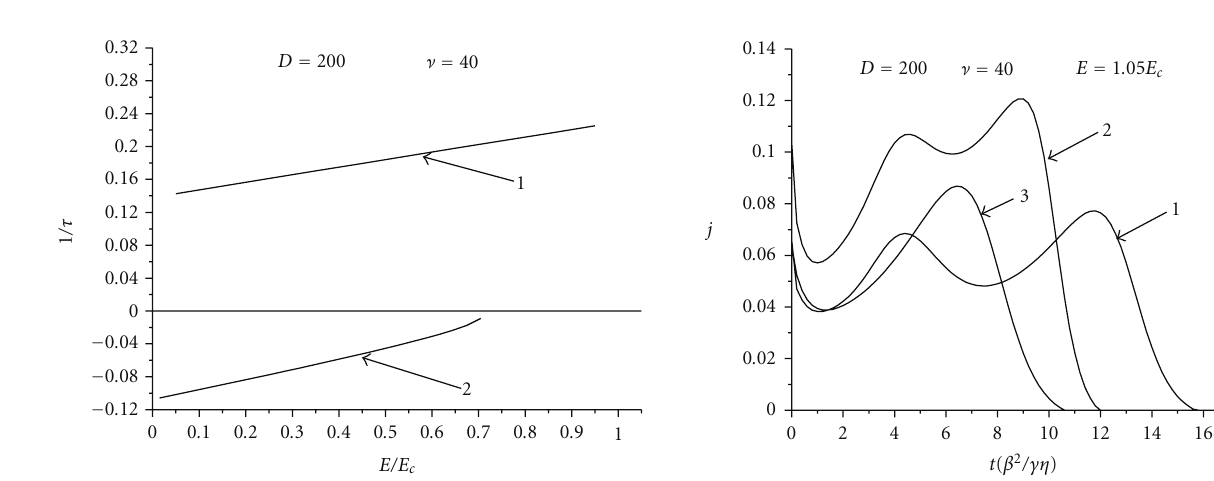
Figure 4: Dependence of the switching current j on time t (in units of γη/β 2 ) during the polarization reversal process in the systems undergoing first-order and second-order phase transitions (transition from the first stable state to the second one). The values of dimensionless temperature for the system undergoing a first- order phase transition are δ = 0 . 9835 (curve 1) and δ = 0 . 7407 (curve 2). The value of θ for the system undergoing a second-order phase transition is θ = 1 . 6 (curve 3). The number of dipoles is 64 × 64. The initial state corresponds to the ferroelectric state with a nucleus of the second domain of polarization of the opposite polarization orientation (the size of the nucleus is 4 × 4). The value of the applied electric field is E = 1 . 05 · E c , ν = 40, D = 200 .